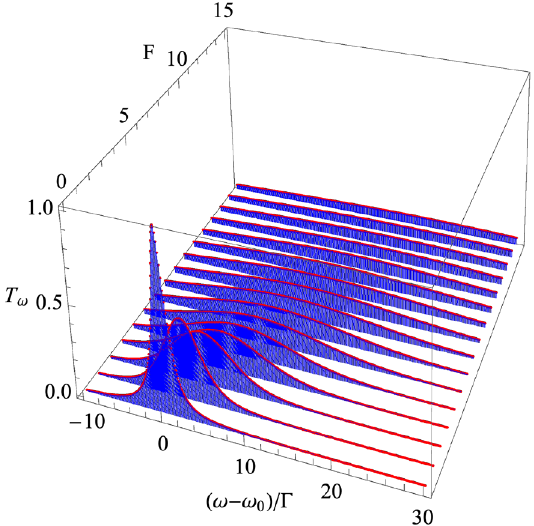
Figure 3. Transmission spectrum T ω as a function of the frequency and F . The curve at equilibrium regime 0 represents Lorentzian τ ω of the width Ŵ . The increase of F turns the nonequilibrium regime on and F = T ω become Gaussian with κ > Ŵ . Maxima of T ω at each F are located at shifted frequency F ε/ 2 ; here, 2 Ŵ L Ŵ R Ŵ/ 2 and ε/Ŵ = = =